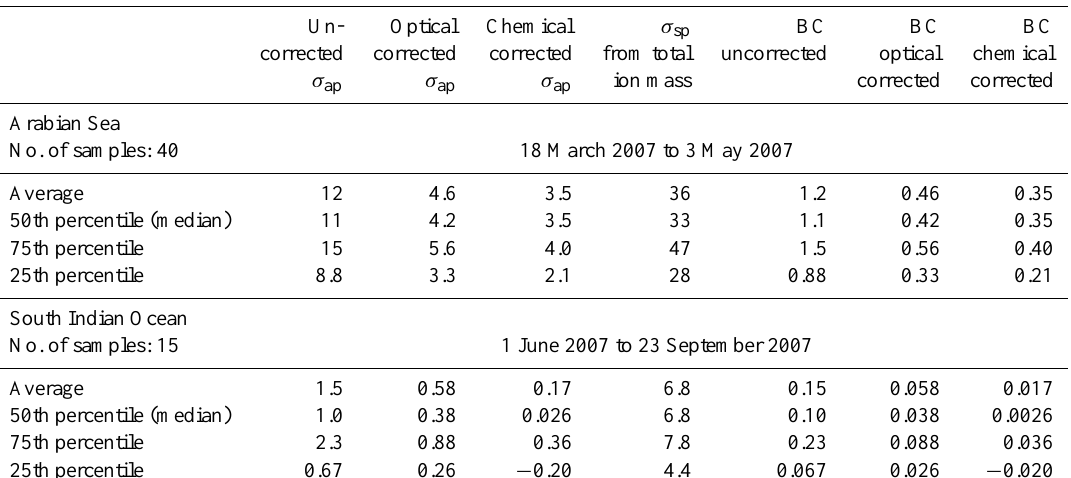
Table 2. Samples collected at MCOH during the two data selections. Data shown are uncorrected absorption coefficient ( σ ap ) values and BC mass concentrations, data corrected with the optical protocol and data corrected with the chemical protocol. Also shown are scattering coefficient ( σ sp ) values calculated using measured ion mass and a mass scattering efficiency of 3.8m 2 g − 1 . Units for ( σ ap ) and ( σ sp ) are in Mm − 1 and for BC mass concentration in µgm − 3 . BC mass concentrations were derived using a mass absorption cross-section of 10 ± 1m 2 g − 1